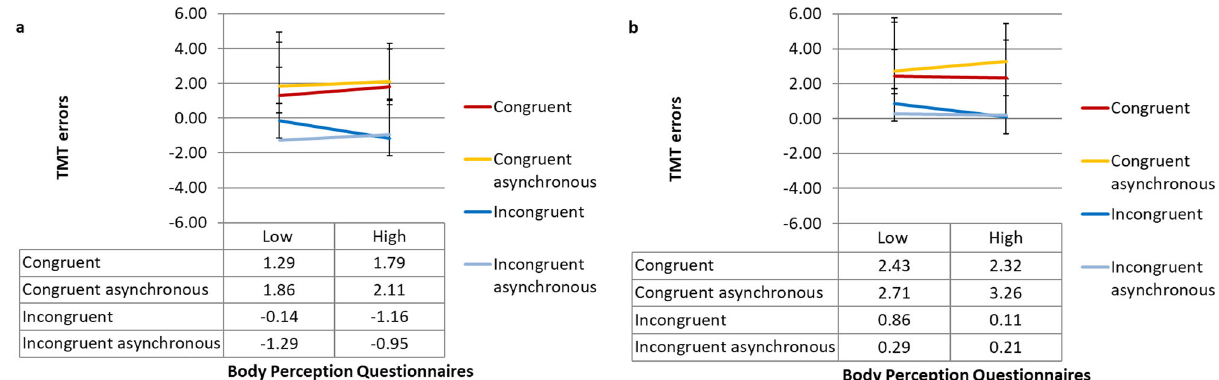
Fig. 3 Visuo-thermal illusion effect following the illusion trials as a function of Body Perception Questionnaires (BPQ) scores for Experiment 2. For the increasing ( a ) and the decreasing conditions ( b ). For visualisation purposes, we used a median split method to categorize BPQ scores into low and high groups. Error bars denote ±1 standard error of the mean. See Supplementary Fig. 4 for fi gures with individual